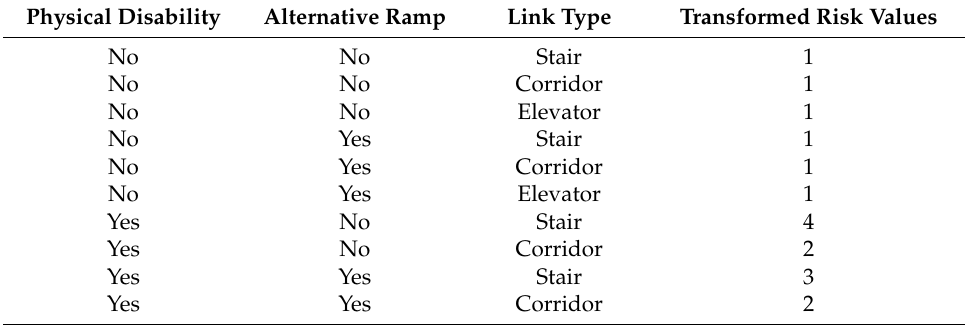
Table 2. Consideration of three factors as a risk value (physical disability, alternative ramp and link